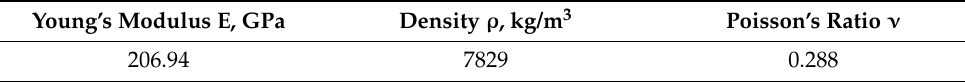
Table 3. FE formulations considered in the comparative